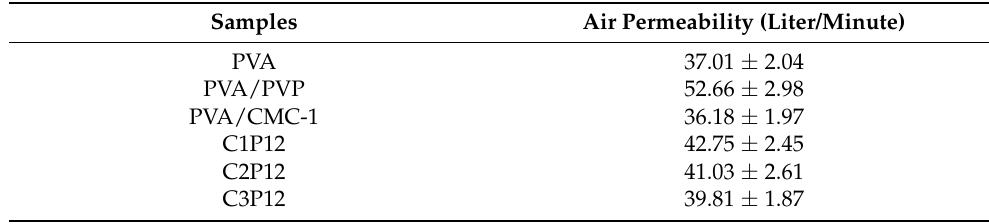
Table 2. Air permeability of PVA, PVA/PVP, and CMC based composite